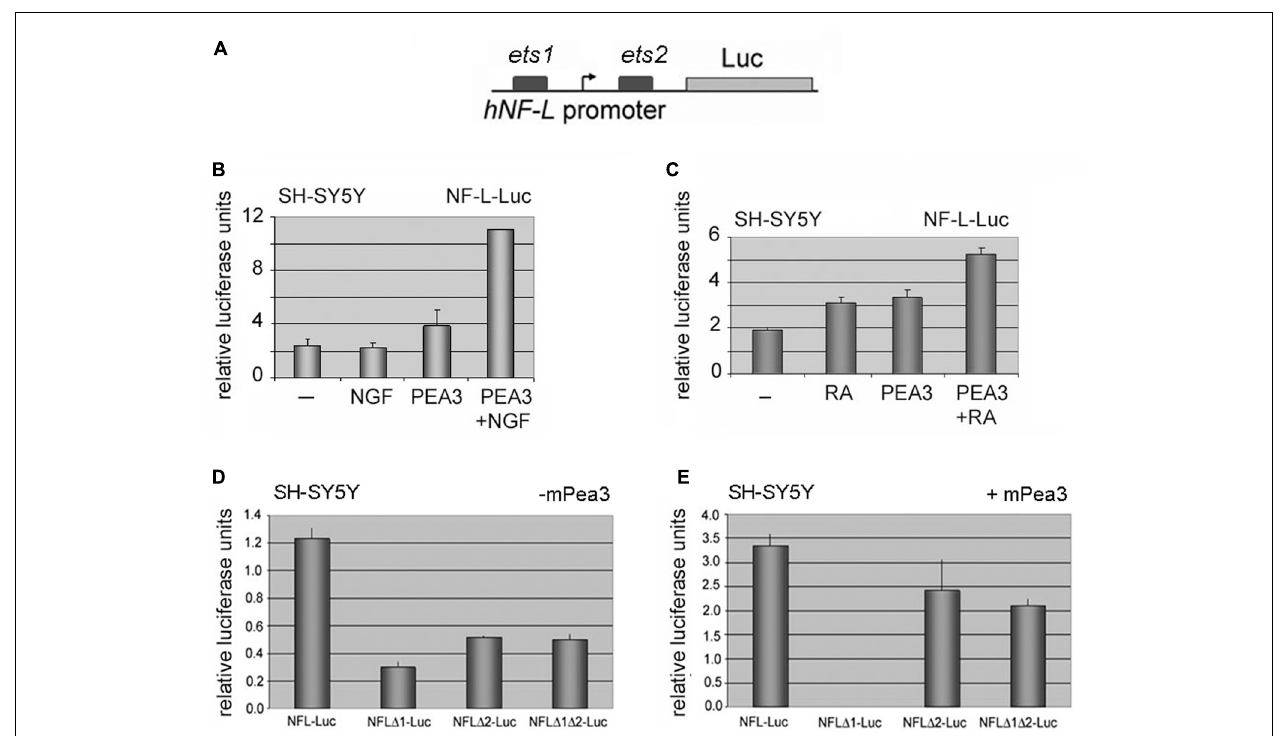
co-transfected with wild type NF-Lgene promoter driven luciferase reporter plasmid or with NF-L gene promoter which lacks putative Pea3 binding sites ets-1 (NFL (cid:2) 1-Luc) or ets-2 (NFL (cid:2) 2-Luc) or both (NFL (cid:2) 1 (cid:2) 2-Luc). Relative luciferase activities were monitored in the presence (D) or absence (E) of 200ng of wild type Pea3. Luciferase activities represent reproducible three or four independent experiments, and data plotted for each condition were average of relative luciferase activity of triplicate